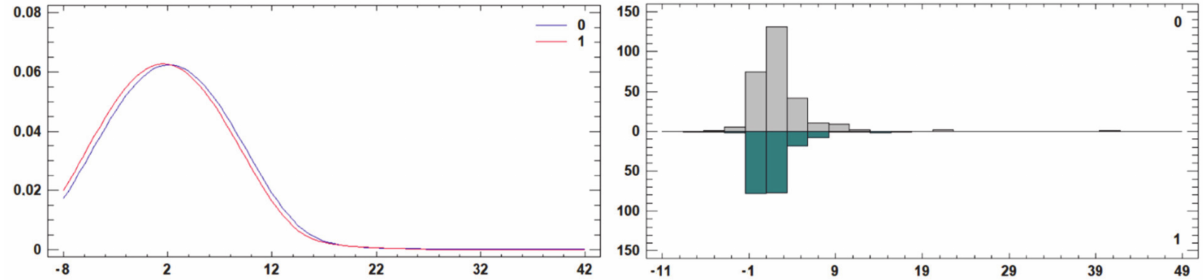
Figure 4. Comparison of the distribution function of results—Altman model. Legend: 0—agricultural cooperatives,